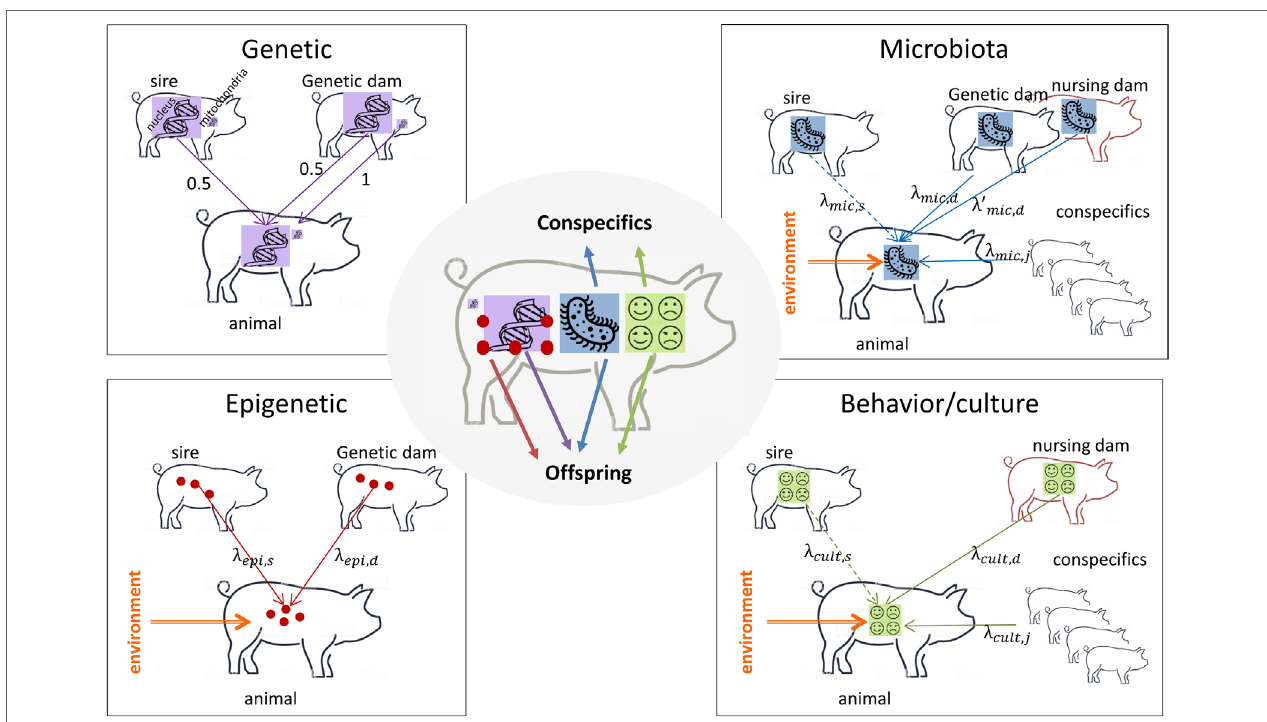
FIGURE 1 | What an animal receives and transmits. Purple arrows: DNA transmission; red arrows: epigenetic mark transmission; blue arrows: microbiota transmission; green arrows: behavior/culture transmission; orange arrows: environment that modifies the transmitted information support. Dotted lines: transmission for specific types of livestock only when the sire is in contact with his offspring (meat sheep, meat cattle). Genetic : sire and genetic dam transmit half of their DNA to their offspring (with the particularity of sex chromosomes X and Y that are not identical and mitochondrial DNA that is transmitted by the dam only). Epigenetic : sire and genetic dam transmit part of their epigenetic marks to their offspring, epigenetic marks are modified by the environment. Microbiota : genetic and nursing dams transmit part of their microbiota to the offspring, conspecifics can share their microbiota with the focal individual. The sire, if present after delivery, can transmit its microbiota to his offspring. Microbiota is modified by the environment. Behavior/culture : the nursing dam transmits part of her behavior to the offspring, the focal individual can learn from conspecifics and from its sire if present after delivery. Behavioral traits can be modified by the environment (stressful situations for instance). An animal transmits all factors to its offspring, microbiota and culture to